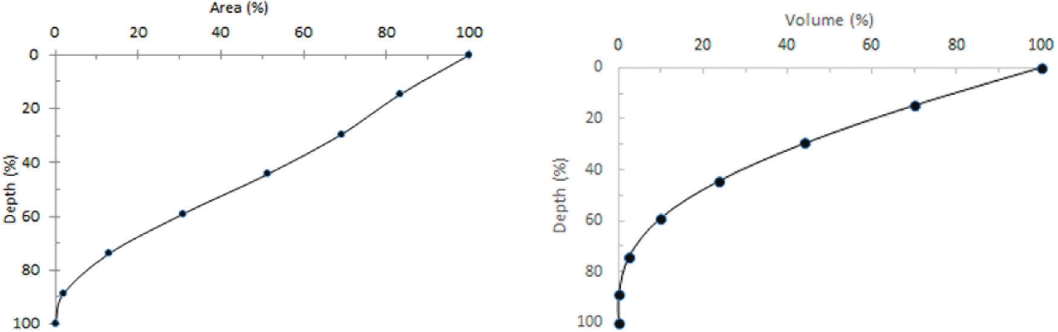
Figure 4 - Hypsographic curves of area and